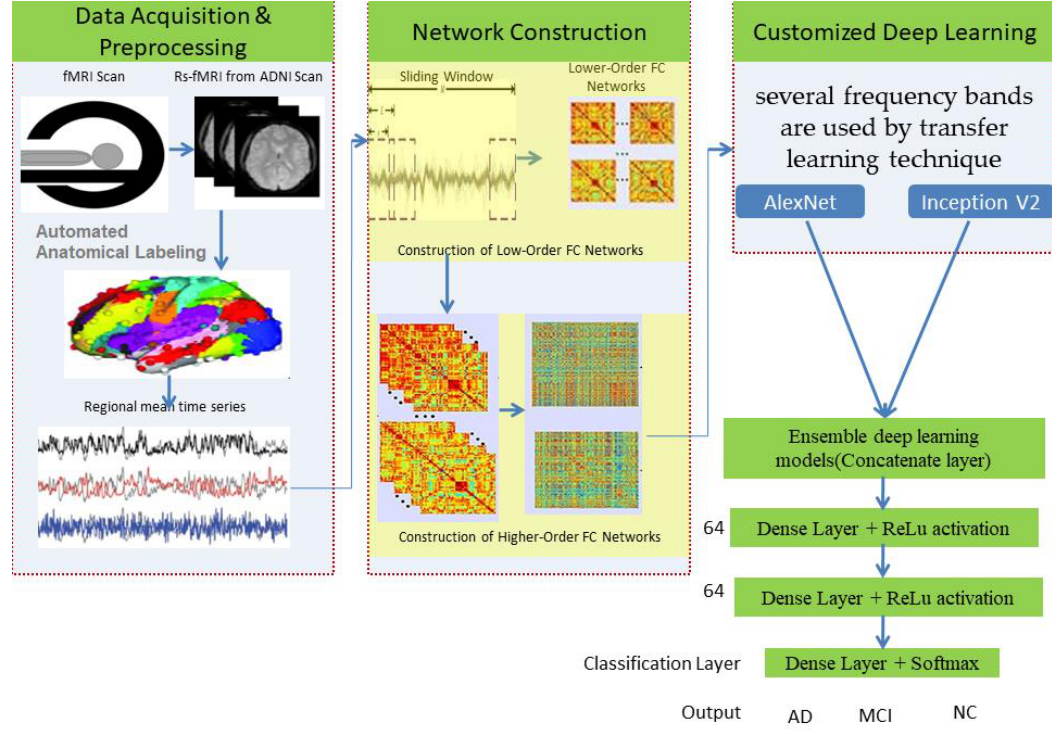
Figure 1. Proposed model using deep networks.